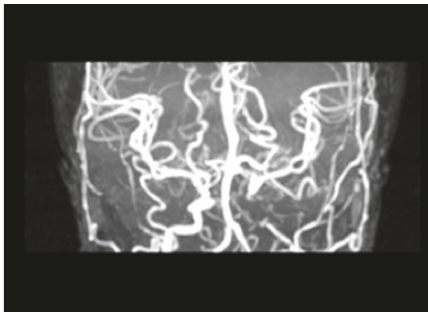
Figure 2: Magnetic resonance arteriography in patient with tha- lassemia major showed complete occlusion of left internal carotid and diffuse